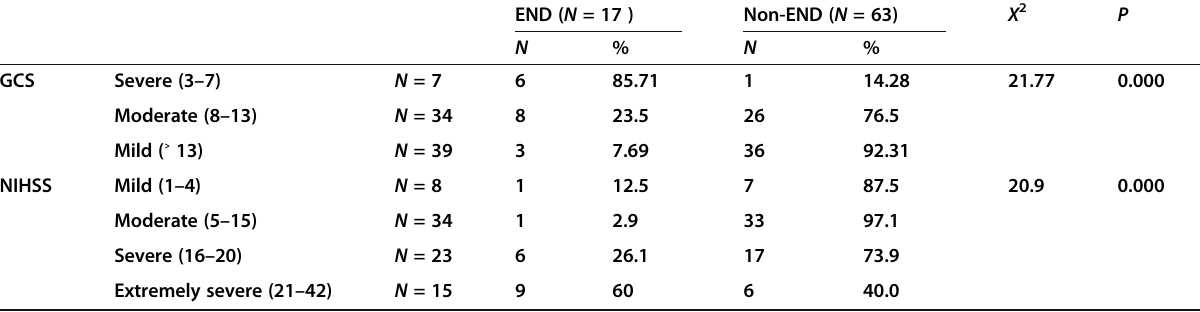
Table 1 Association of early neurological deterioration (END) with Glasgow Coma Scale (GCS) and the National Institutes of Health Stroke Scale (NIHSS)